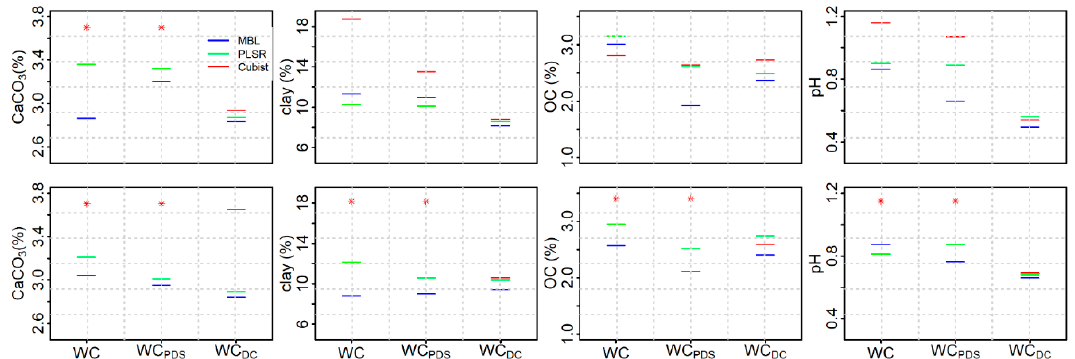
Figure 4. Root mean square error (RMSE) of Woodwell (WC), Woodwell PDS (WC PDS ) and Woodwell DC (WC DC ) spectra representing independent validation set of the European origin (set III) for all three modeling approaches (MBL, PLSR and Cubist). The top and bottom panel shows the RMSE estimated using the prediction from the baseline corrected and first derivative spectra, respectively. The Woodwell DC (WC DC ) are the Woodwell (WC) spectra predicted using the direct calibration and leave-one-out cross validation. The red asterisk symbol shows that the RMSE using Cubist are too high to be included within the y -axis range for the given soil property.